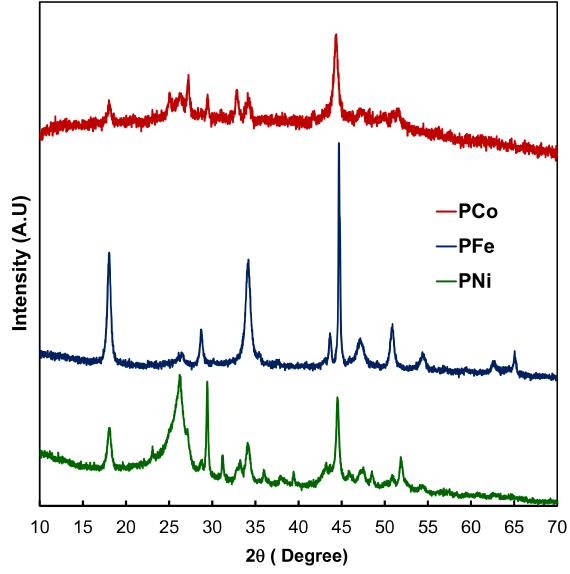
Figure 3. XRD patterns of the composites. Table 3. Superficial chemical content of the composites determined by